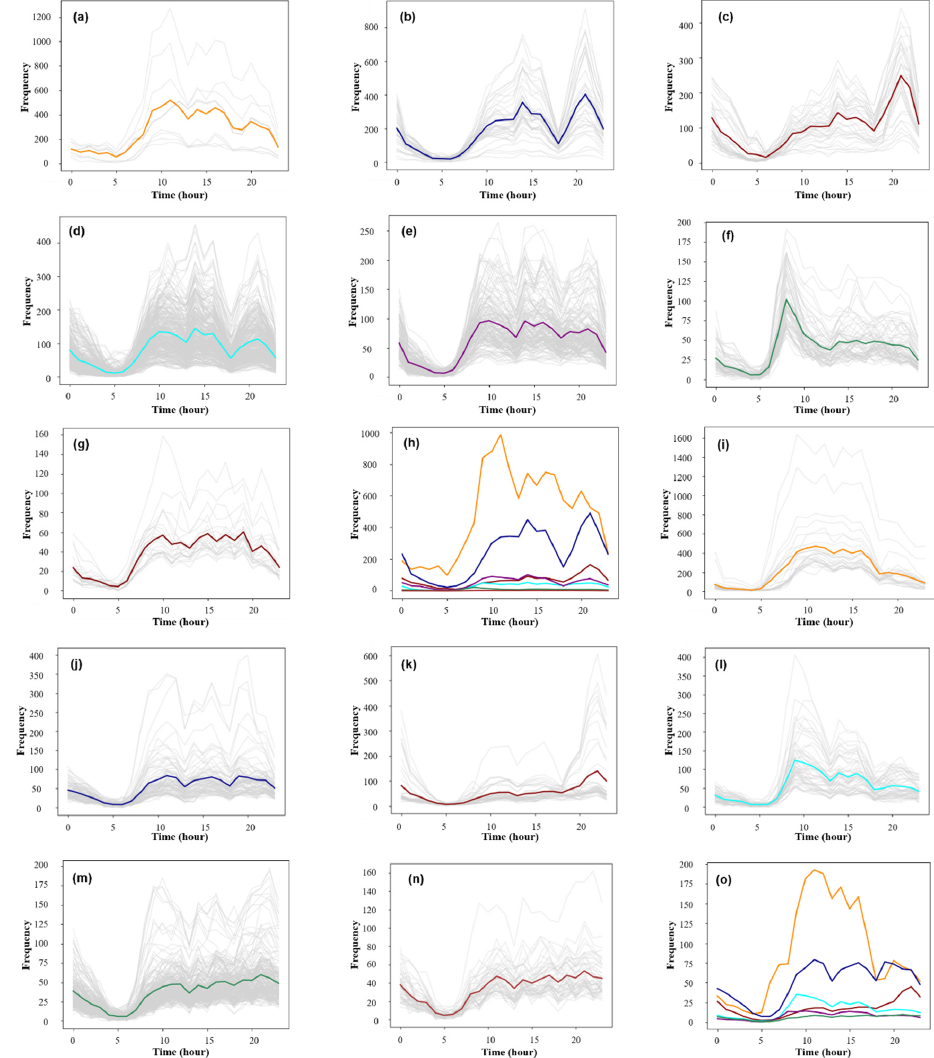
Figure 9. ( a – h ) The departure time series of the collective human mobility patterns on weekdays and ( i – o ) the arrival time series of the collective human mobility patterns on weekdays. ( i – o ) the arrival time series of the collective human mobility patterns on